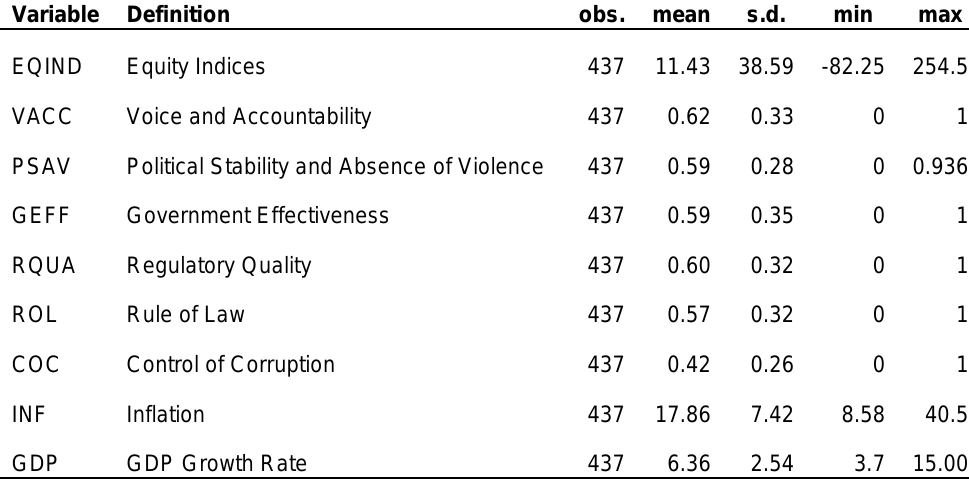
Table 4. Definition of variables and summary